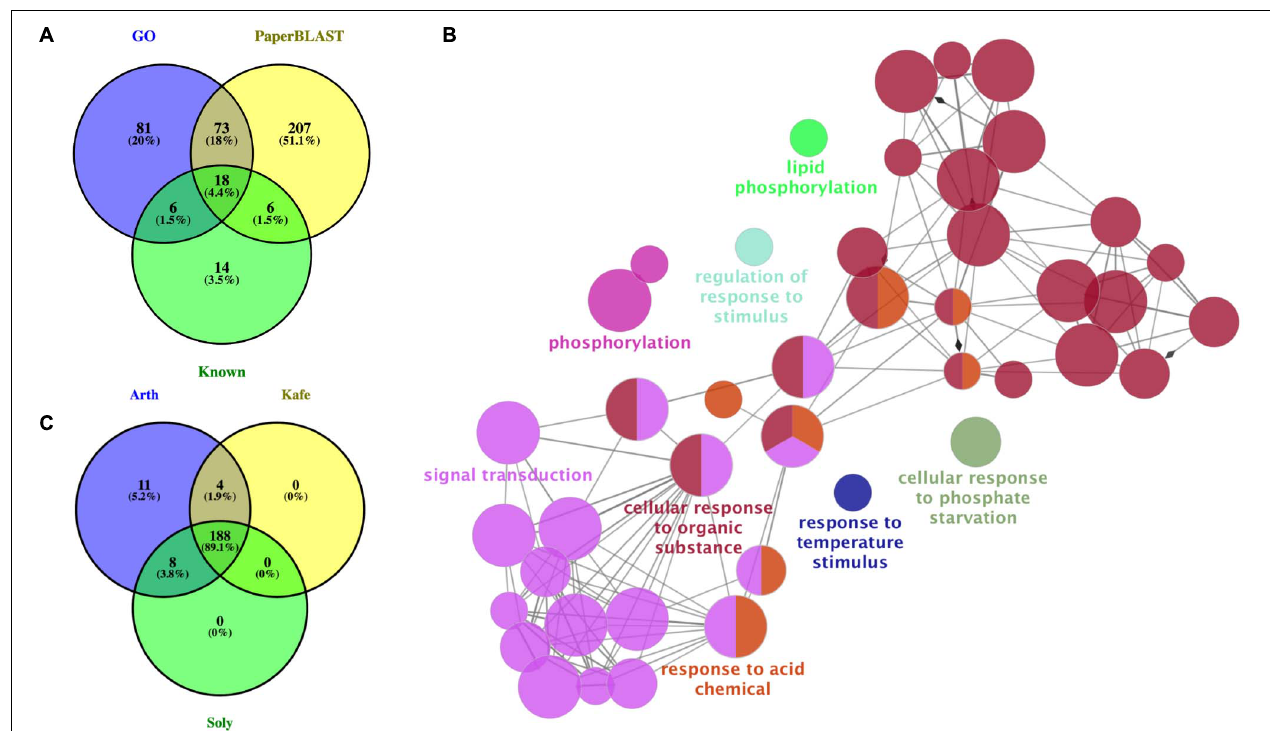
FIGURE 2 | Assessment and identification of new stomata-related genes. (A) Overlap of Arabidopsis thaliana genes with annotations related to stomata, known as key stomatal genes, and identified in PaperBLAST database as stomata-related. GO: genes annotated as stomata-related from Gene Ontology analysis. Known: genes known as stomata-related from the literature. PaperBLAST: stomata-related genes identified by using PaperBLAST search. (B) Gene ontology enrichment of the 207 new A. thaliana stomatal genes. (C) Overlap of ortholog groups between new stomata-related genes in A. thaliana (Arth), Solanum lycopersicum (Soly), and Kalanchoë fedtschenkoi